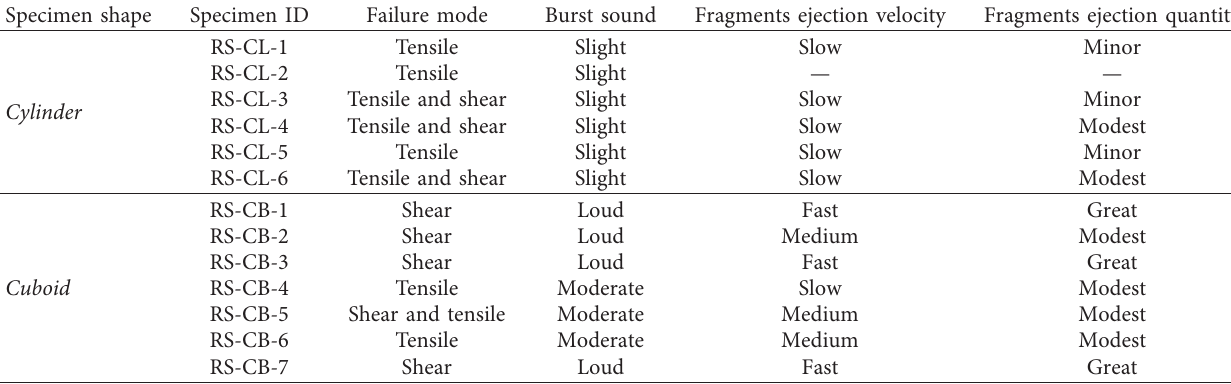
Table 6: Ejection characteristic information of